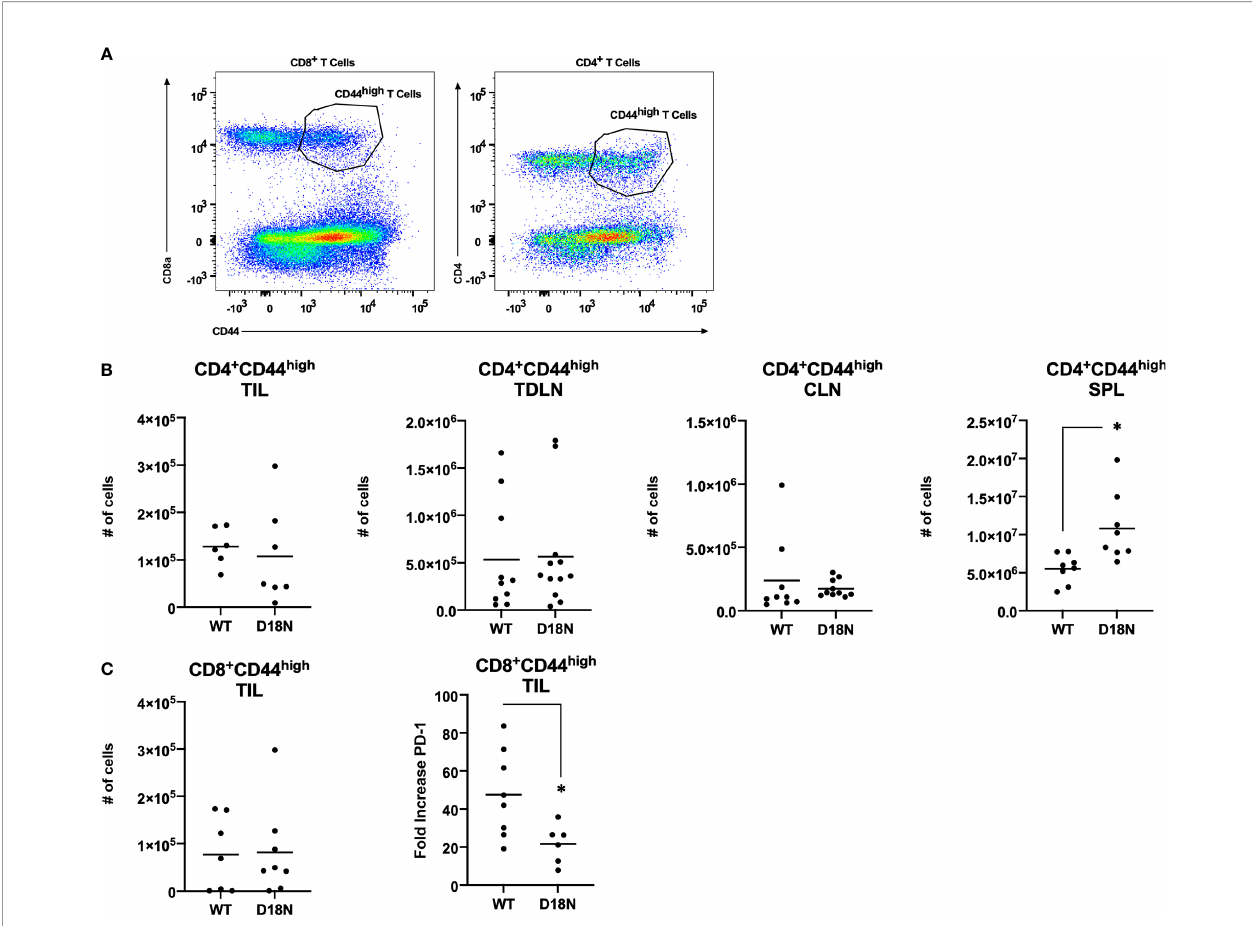
FIGURE 4 | Similar T-Cell Number but Decreased PD-1 Expression in TREX1 D18N Mice During Tumor Progression. (A – C) WT or D18N mice were challenged with 5x10 6 H31m1 cells, cells were isolated from the indicated tissue on Day 8, and (A) activated/memory CD4 + and CD8 a + CD44 high T-cells were measured by fl ow cytometry (see Methods). Numbers of indicated (B) CD4 + or (C) CD8+ T cells were determined. ‘ SPL ’ = spleen, ‘ CLN ’ = contralateral lymph nodes, ‘ TDLN ’ = tumor draining lymph node, and ‘ TIL ’ = tumor in fi ltrating lymphocytes. (C) PD-1 M.F.I. on activated/memory CD8 + CD44 high T-cells in the tumor were determined, and the fold change compared to naïve T-cells in the spleen was calculated (see Methods). Individual mice (6-9 total, 3 independent experiments) are plotted, with averages represented by horizontal bars. *p-value < 0.05 via two-tailed independent Student ’ s t-test. All graphs prepared in Prism 9.0